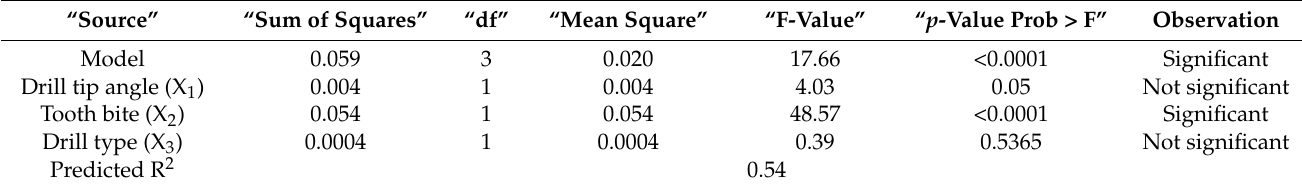
Table 6. Analysis of variance results in the case of a regression equation that was developed for the delamination factor at the inlet.